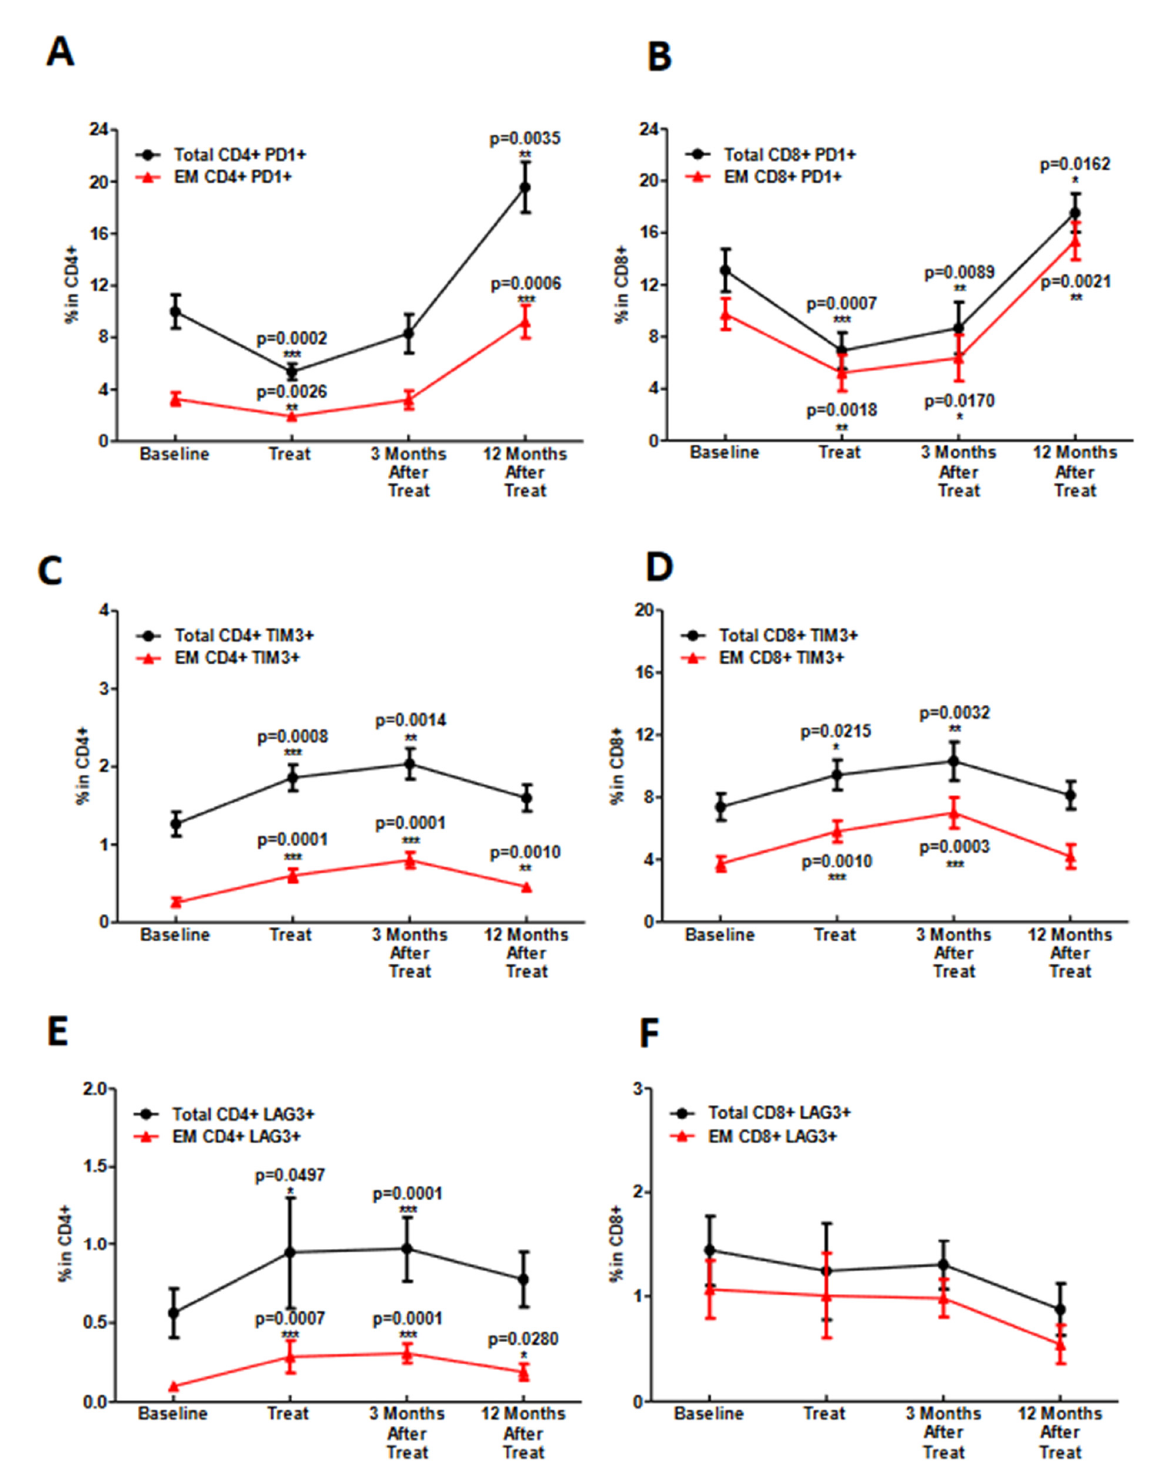
Figure 4. Effect of PD-1 blockade during chemoradiotherapy on PD1, TIM3 and LAG3 expression on circulating T cells. ( A , B ) time course of changes in the relative number of PD-1+ CD4+ and CD8+ T cells expressed as percentage of total CD3+CD4+, CD3+C8+ and EM T cells (CD3+CD4+ CD45RA − CCR7 − , CD3+CD8+ CD45RA − CCR7 − ). ( C,D ) time course of changes in the relative number of TIM3+ CD4+ and CD8+ expressed as percentage of total CD3+CD4+, CD3+C8+ and EM T cells. ( E , F ) time course of changes in the relative number expressed as percentage of total CD3+CD4+, CD3+C8+ and EM T cells of LAG3+ CD4+ and CD8+ T cells. * ( p ≤ 0.05), ** ( p ≤ 0.01) and *** ( p ≤ 0.001) with respect to